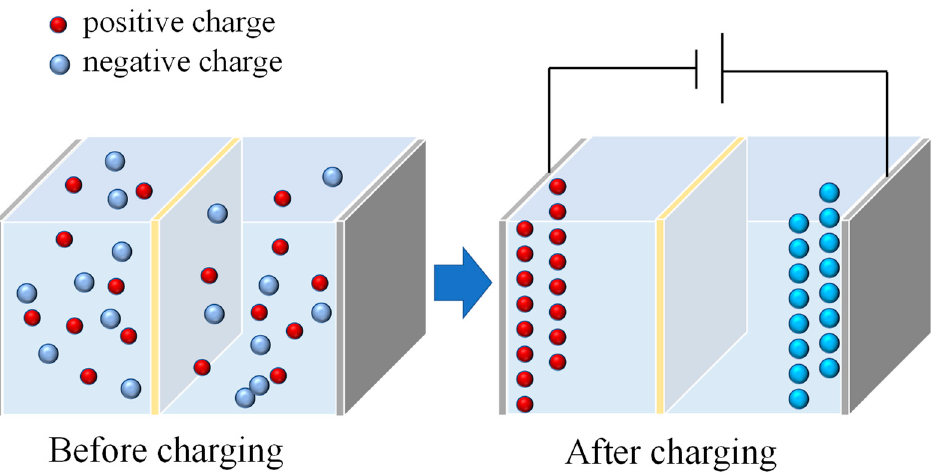
Figure 1. Operating principle of supercapacitors. Positive and negative charges are stored on the positive and negative plates, respectively, when the electrodes are connected to the external cir- cuit.